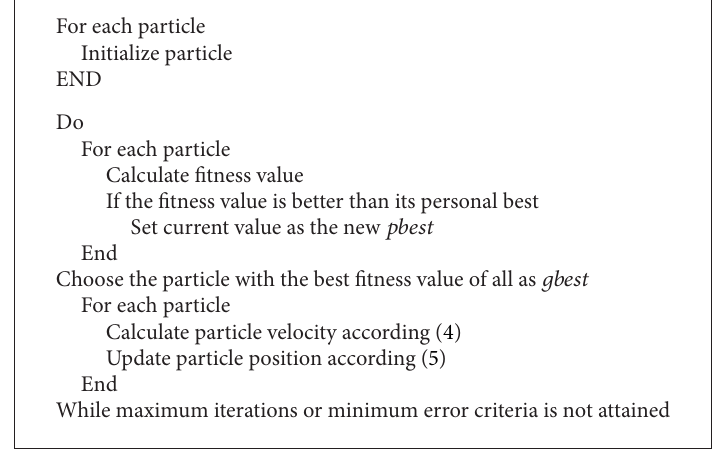
Pseudocode 1: Pseudocode for PSO.